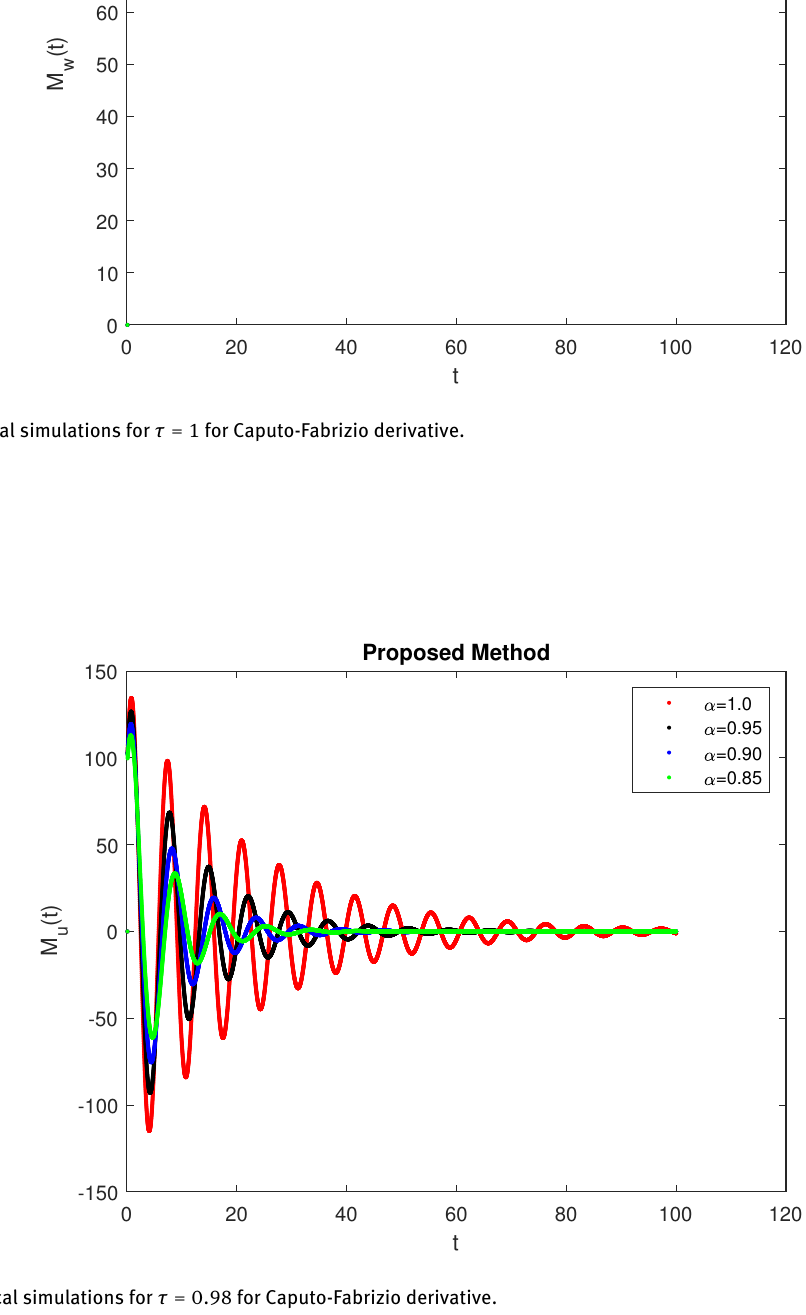
Figure 22: Numerical simulations for τ = 0.98 for Caputo-Fabrizio